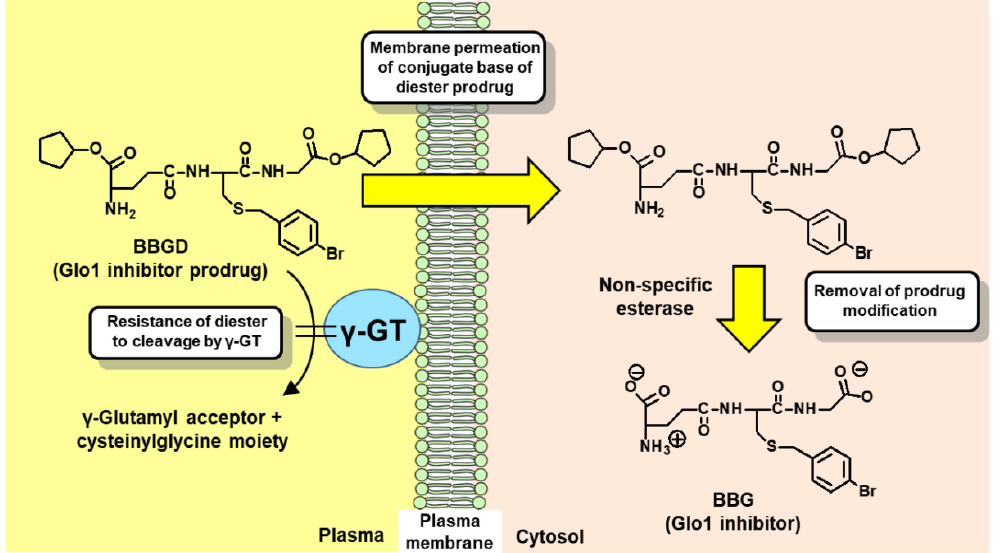
Figure 3. Delivery of glyoxalase 1 inhibitor, S-p-bromobenzylglutathione, into cells by diester modification. Abbreviations: BBG, S-p-bromobenzylglutathione; BBGD, S-p-bromobenzylglutathione cyclopentyl diester; and γ -GT, γ -glutamyl transferase.